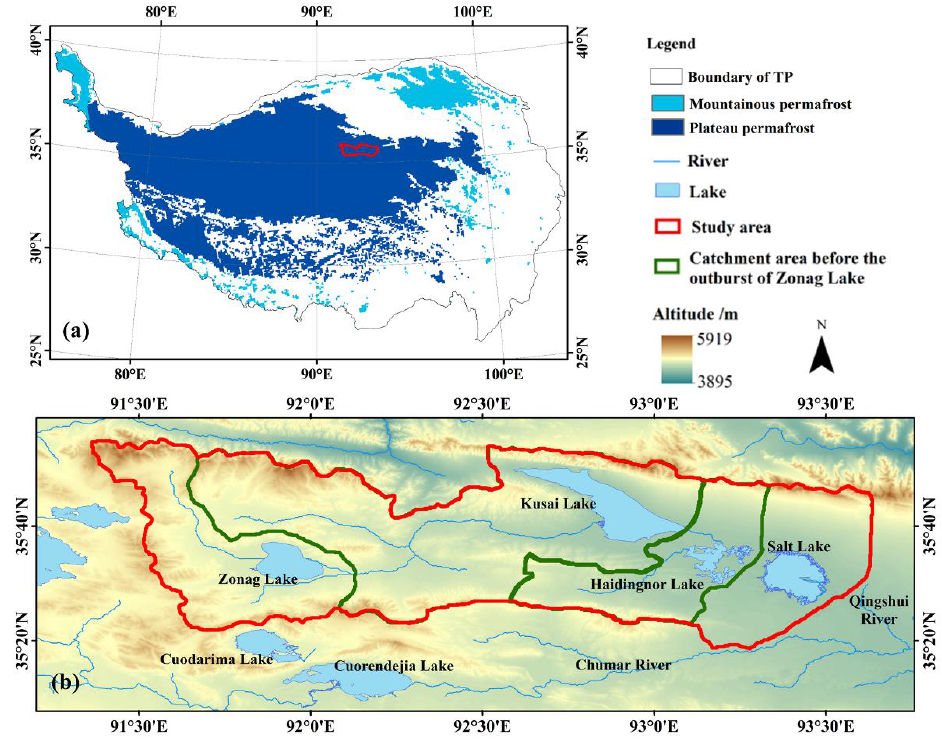
Figure 1. Overview of the study area: ( a ) the permafrost on the TP; ( b ) the topography and lake distribution of the study area.